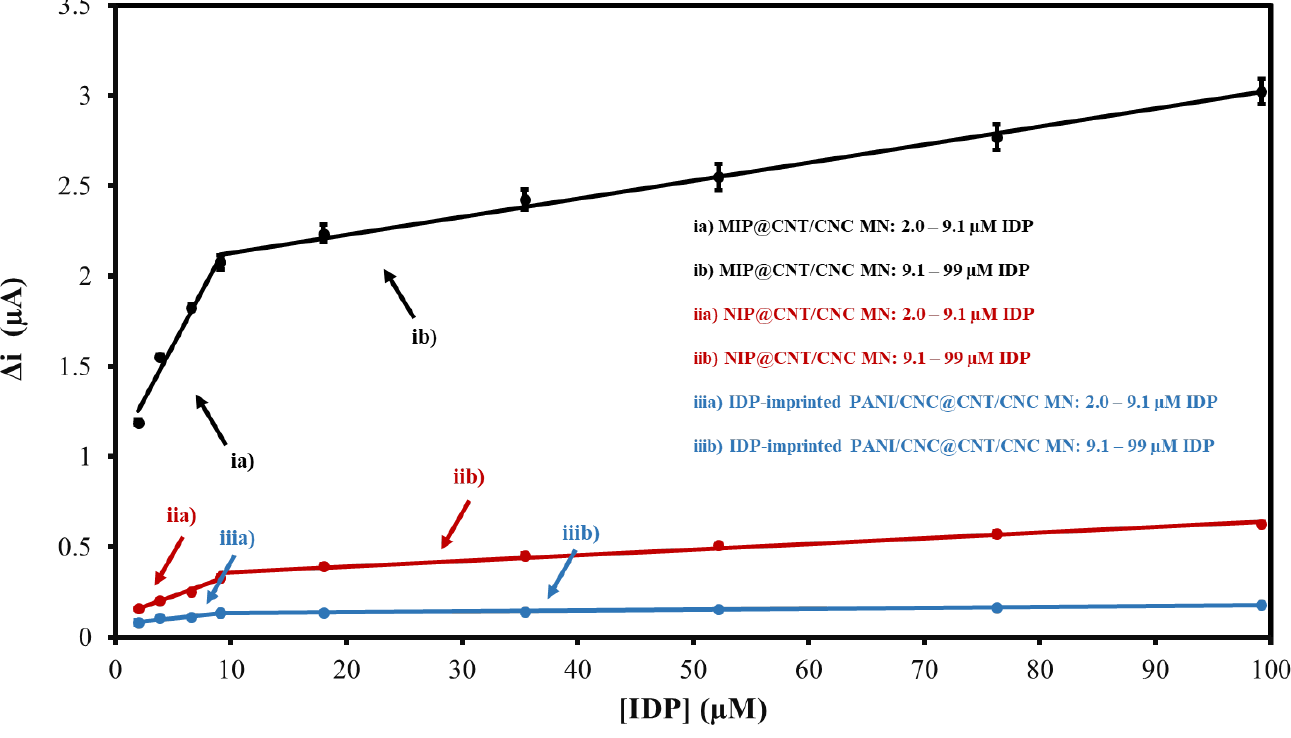
Figure 6. CV average current (Δi) vs. imidacloprid (IDP) concentration calibration curves for (ia)